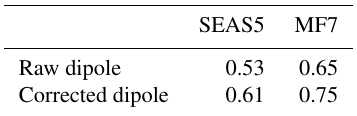
Table 1. Correlation between the dipole values derived from the seasonal models (SEAS5 and MF7) and the one derived from ERA5. The “Raw dipole” represents the dipole computed using raw forecasts and “Corrected dipole” that using the bias-corrected fore-